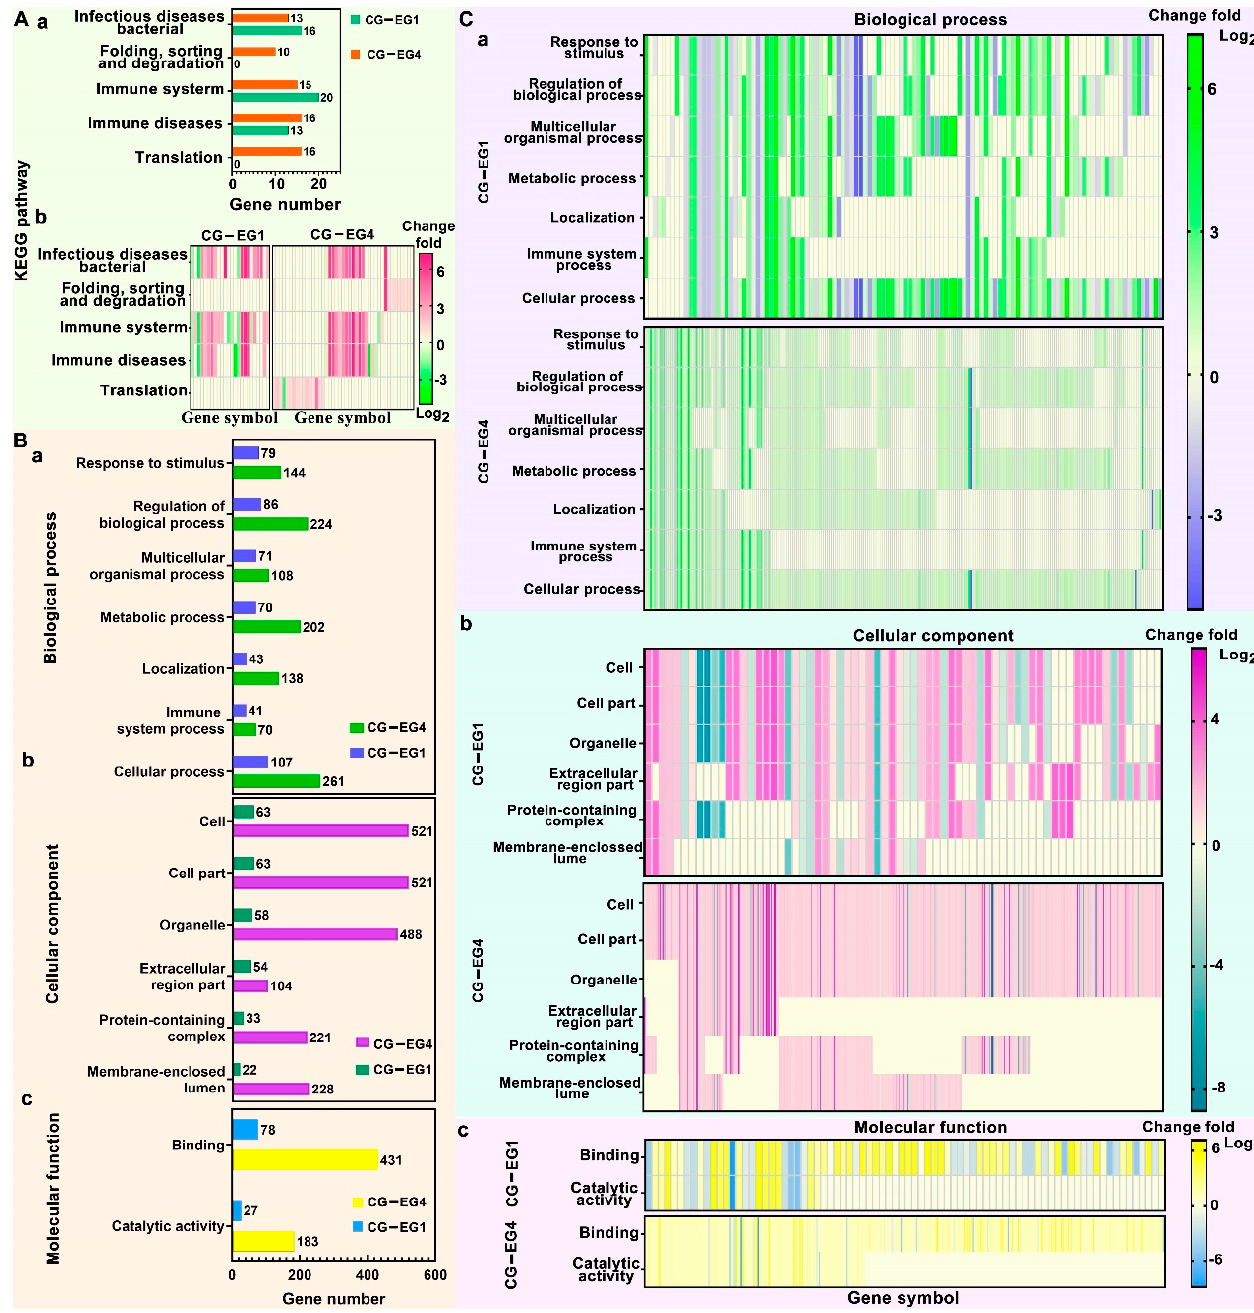
Figure 6. ( A ), KEGG pathway enrichment analysis in EG1 group and EG4 group compared with CG group, n = 3, p < 0.001. ( A-a ), the histogram of pathways changed and their corresponding genes’ number. ( A-b ), the heat maps of the change folds of genes in these corresponding pathways in EG1 and EG4 group compared with CG group. ( B , C ), GO term enrich analysis in EG1 group and EG4 group compared with CG group. GO term enrich analysis were divided into three parts, the biological process, the cellular component, and the molecular function, n = 3, p < 0.001. ( B ), the histogram of changed terms both in EG1 group and EG4 group compared with CG group, and their corresponding genes’ number. ( B-a ), the biological process, ( B-b ), the cellular component, ( B-c ), the molecular function. ( C ), heat maps of these changed genes’ change folds in their corresponding terms of EG1group and EG4 group compared with CG group. ( C-a ), the biological process, ( C-b ), the cellular component, ( C-c ), the molecular function.